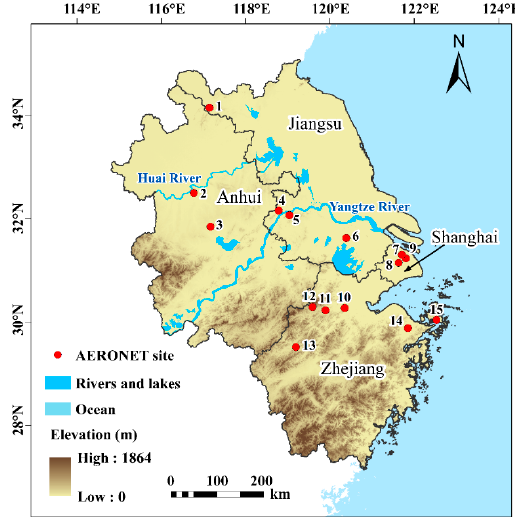
Figure 1. The geographical locations of the PYRD and AERONET sites. Details of these sites are given in Table 2. Data from these sites were used for calibration and validation in Section 3.2.1 and 3.2.2.